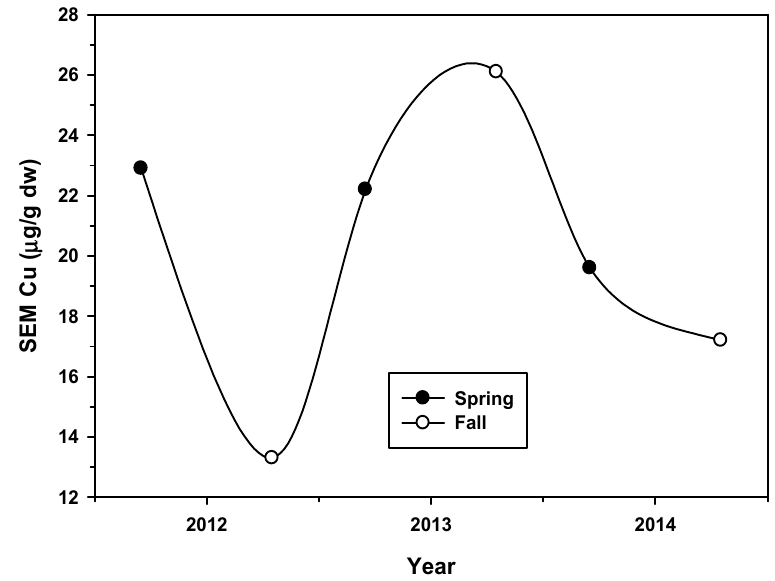
Figure 3. SEM copper concentrations (µg/g dry wt) from spring and fall sediment sampling at Cache Slough site CS-02 for the years 2012, 2013 and 2014.